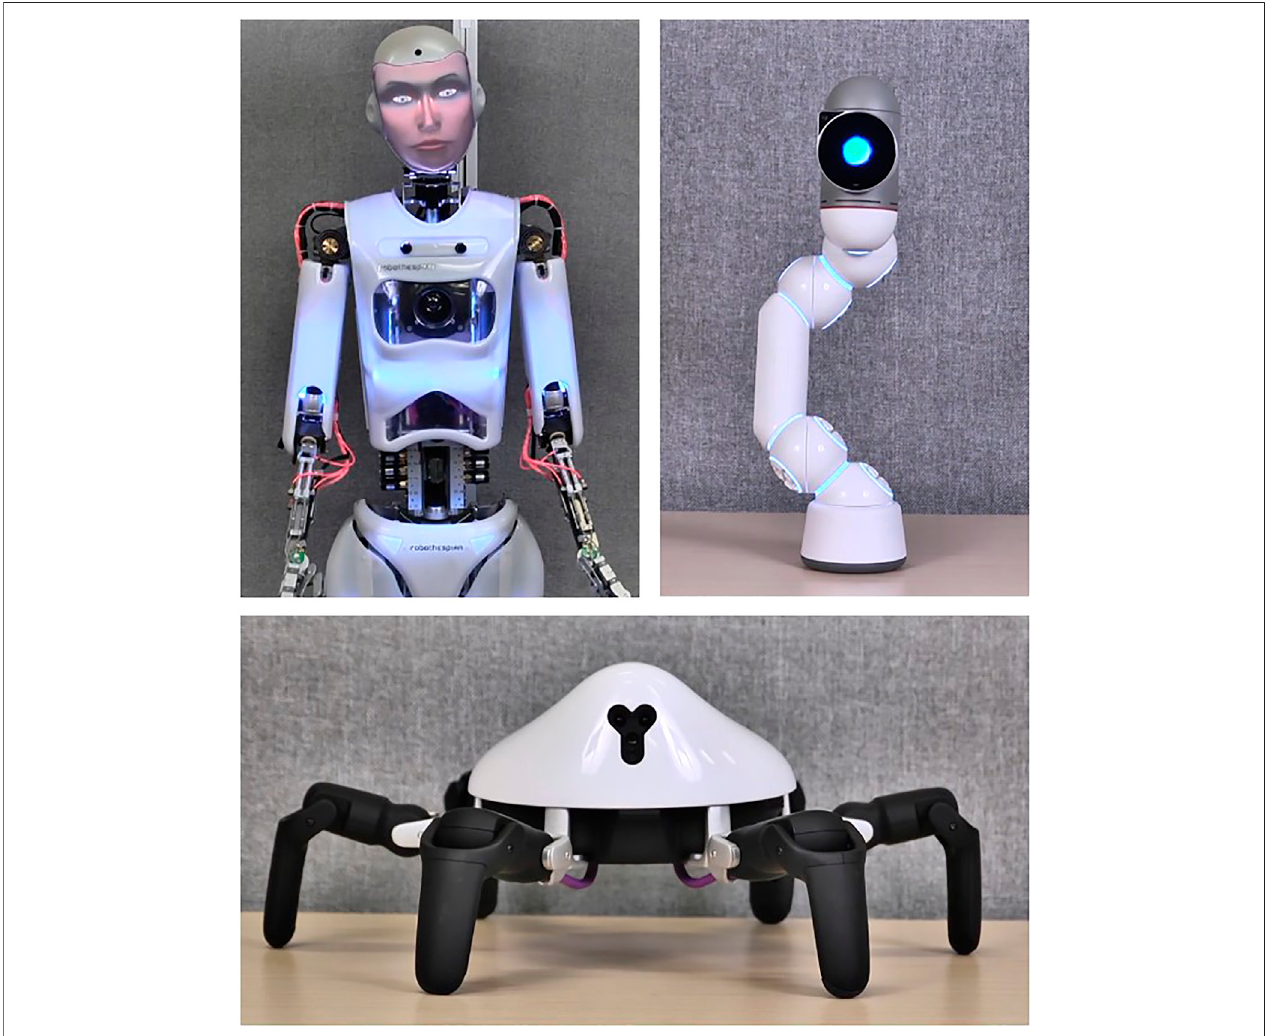
FIGURE 1 | Stimulus robots were anthropomorphic (Robothespian, top left), mechanomorphic (Clicbot, top right), and zoomorphic (Hexa, bottom).